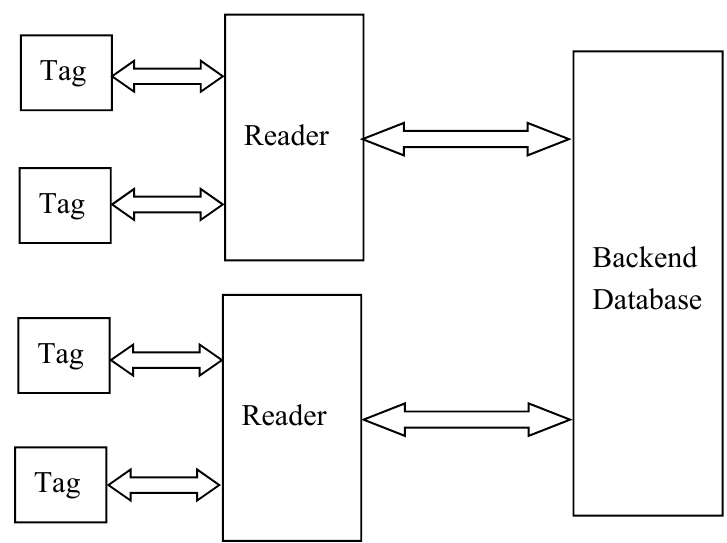
Figure 1. A typical radio frequency identification (RFID) system.